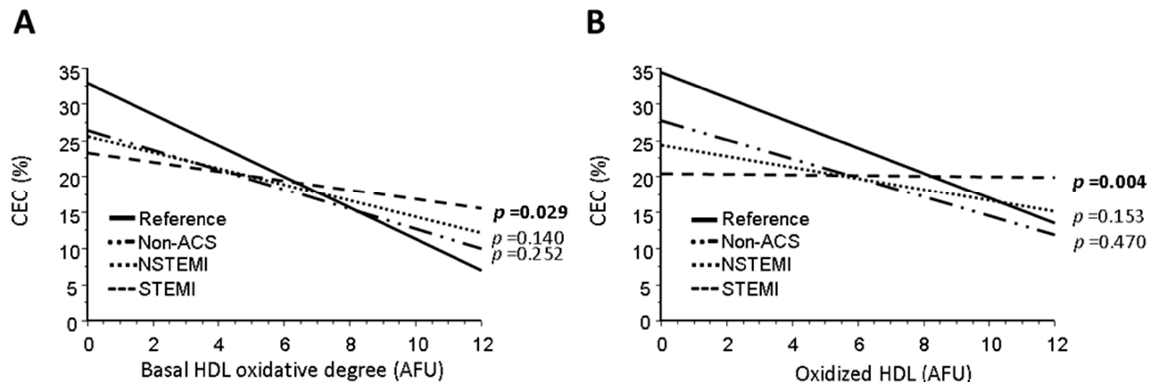
Figure 2. Bivariate regressions. ( A ) Basal HDL oxidative degree (AFU) versus cholesterol efflux capacity (CEC [%]) and ( B ) copper-oxidized HDL (AFU) vs. CEC [%]. Results for the reference individuals, Non-ACS, NSTEMI and STEMI patients. Slope differences of groups versus the reference group (healthy) were assessed by ANCOVA analysis. Values of p < 0.05 are considered significant. Abbreviations: ACS = Acute Coronary Syndrome, CEC = Cholesterol Efflux Capacity, NSTEMI = Non-ST-Segment-elevation myocardial infarction, STEMI = ST-Segment-Elevation Myocardial Infarction, HDL = High Density Lipoprotein.